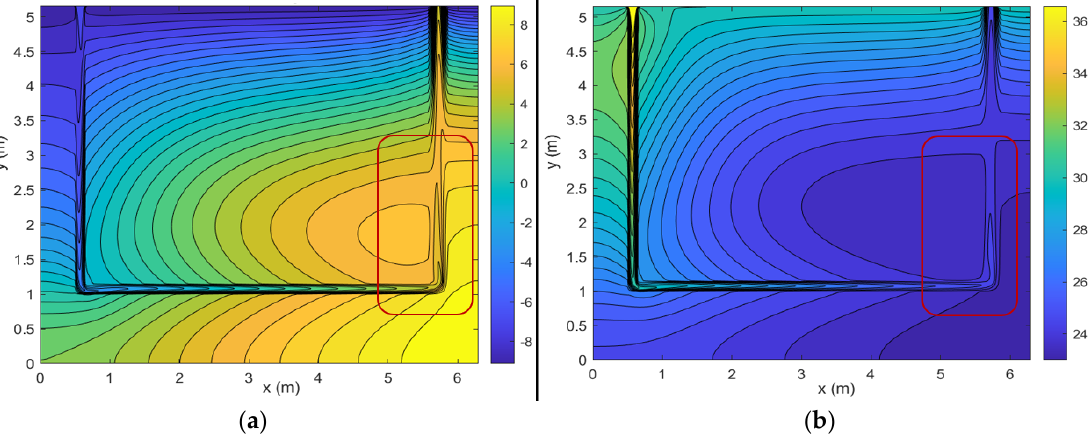
Figure 7. Temperature distribution of the GAHE as ( a ) heating system and ( b ) cooling system, with a burial depth of 4 m and a Reynolds number of 250.